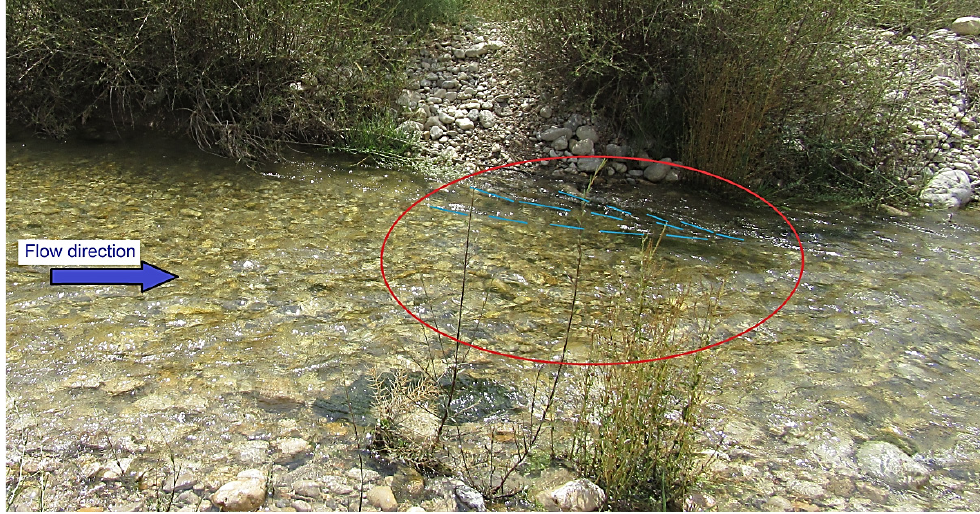
Figure 9. Surface waves and the contraction streamlines, which are visible near the wall of a contraction zone (Marbor River).